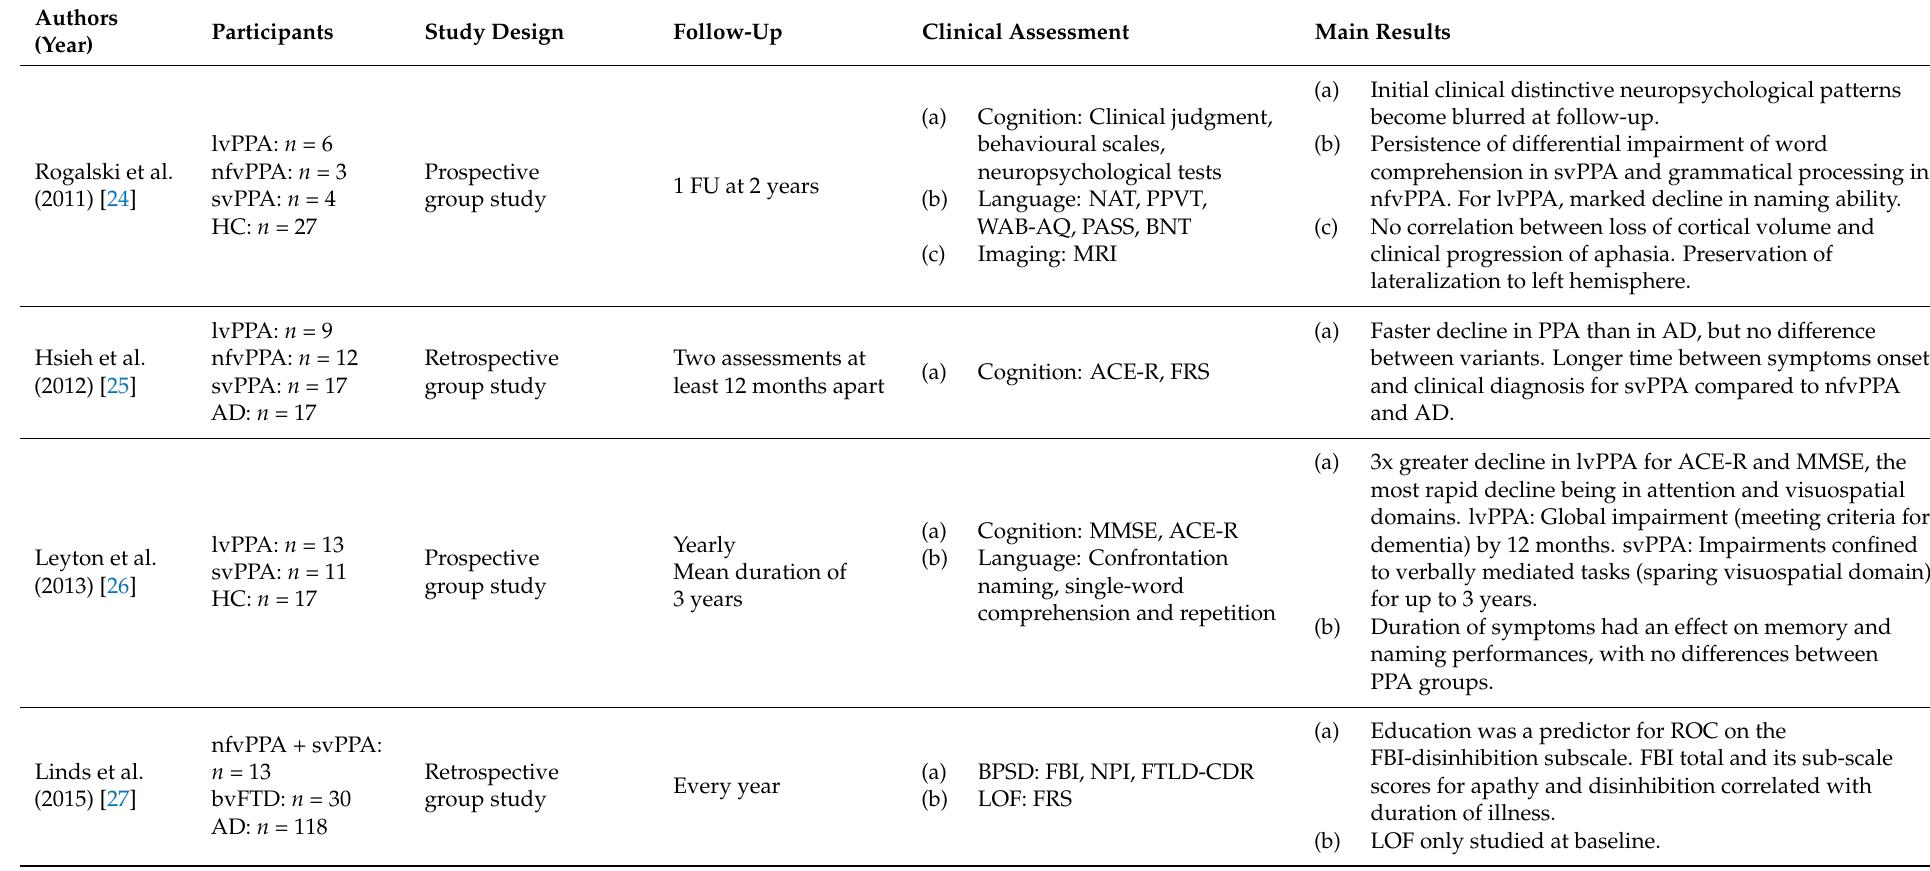
Table 1. Observational studies exploring some elements of the longitudinal changes in cognition, behaviours, and functional abilities in the main PPA